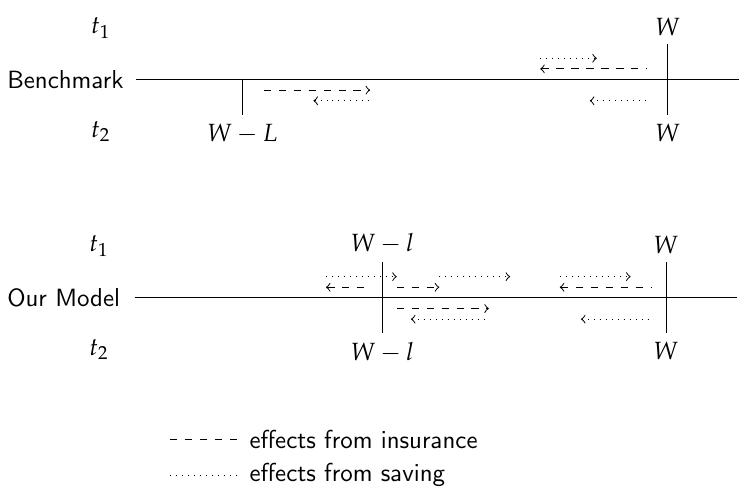
Figure 6. Wealth prospects with insurance and